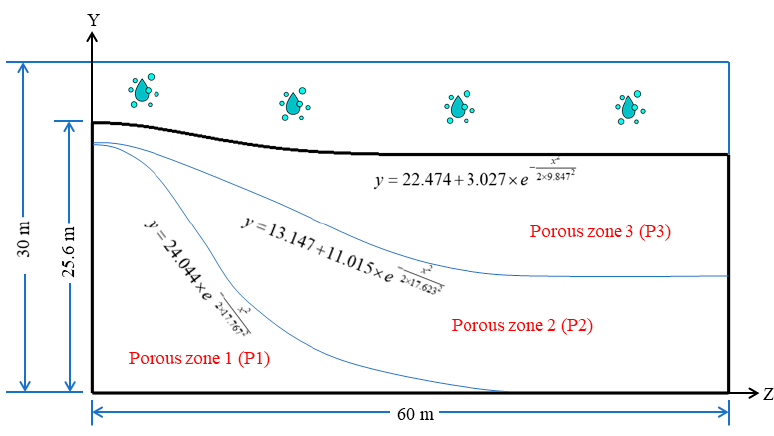
Figure 5. Distribution of three different porous zones in the simulation model.